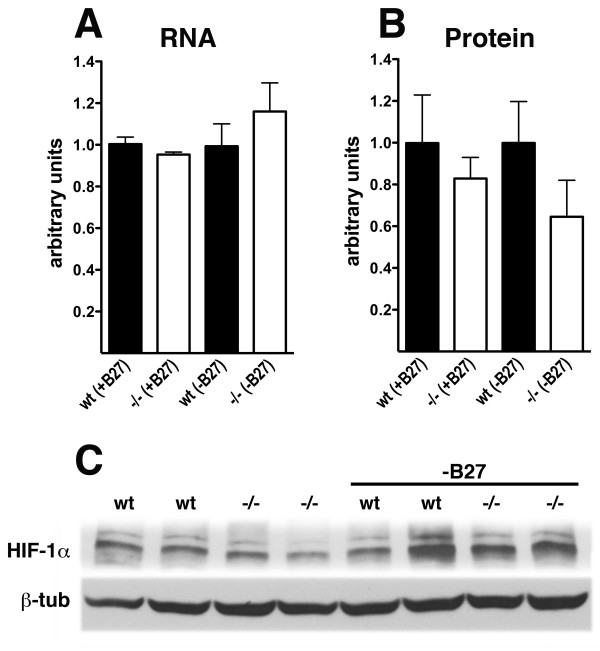
Basal levels of HIF-1α RNA and protein are not significantly changed in Psen1-/- neurons. Basal HIF-1α RNA and protein were measured in neurons in the presence and absence of B27 supplement. In panel A, HIF-1α RNA was measured in neuronal cultures (n = 3/genotype) by qPCR. Samples were run in triplicate and normalized to the geometric means of Ppia and Gusb. In panel B, basal levels of HIF-1α protein were measured in neurons by Western blotting (n = 6 for cultures with B27 and n = 10 for B27 starved cultures). No statistically significant differences were found among the samples (unpaired t-tests). In panel C, representative Western blots are shown of cells cultured with B27 or without (-B27).